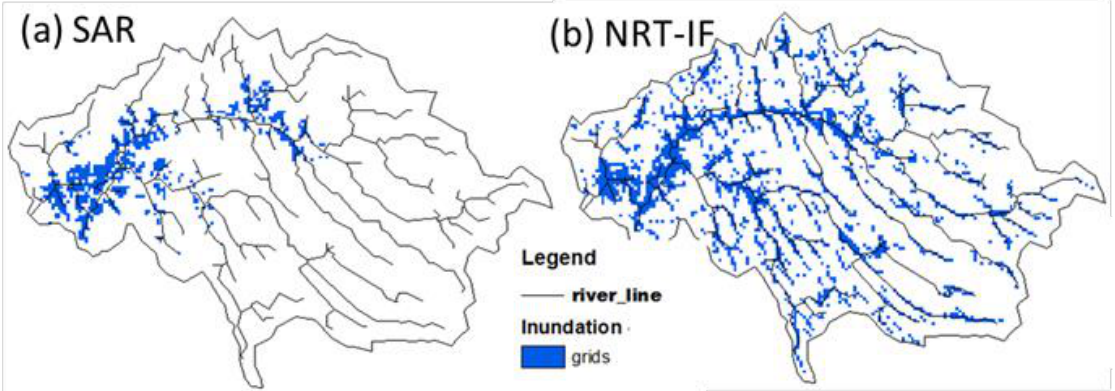
Figure 13. Comparison of flood inundation extents derived for the 2017 flood event in the Kalu River basin: ( a ) SAR and ( b ) GSMaP-NRT .